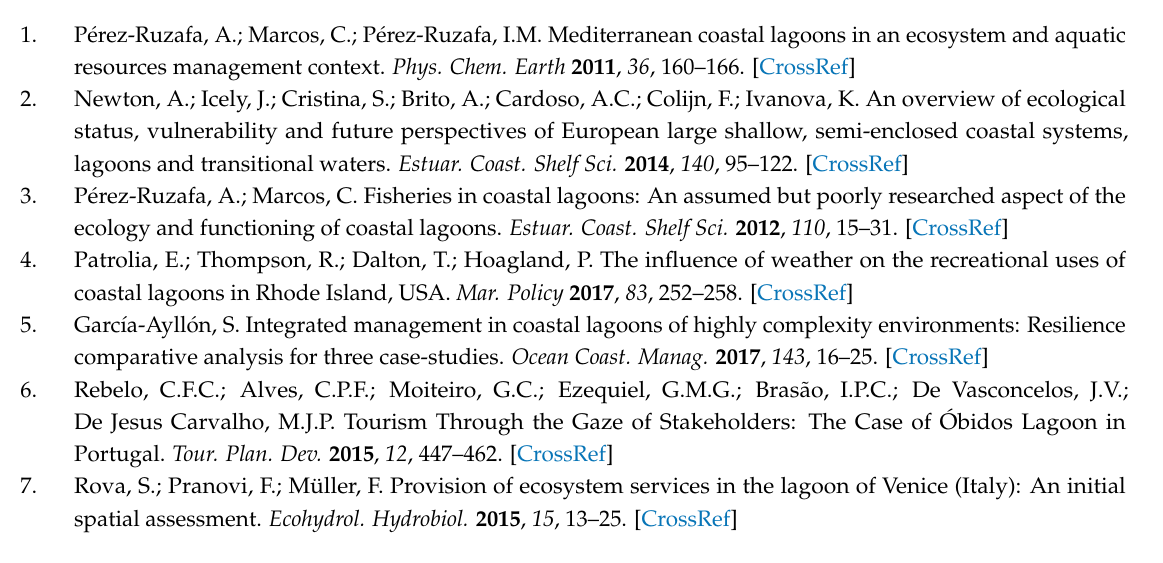
Figure S1: Current speed differences in summer, Figure S2: Current speed differences in fall, Figure S3: Current speed differences in winter, Figure S4: Vertically averaged current speeds, Figure S5: Vertically averaged current speeds in Encañizadas at maximum discharge into the lagoon through El Estacio, Figure S6: Vertically averaged current speeds in Marchamalo at maximum discharge into the lagoon through El Estacio, Figure S7: Vertically averaged current speeds in Encañizadas at maximum discharge out of the lagoon through El Estacio, Figure S8: Vertically averaged current speeds in Marchamalo at maximum discharge out of the lagoon through El Estacio, Figure S9: Current velocity field for winds from the eastern direction, Figure S10: Current velocity field for winds for the southwestern